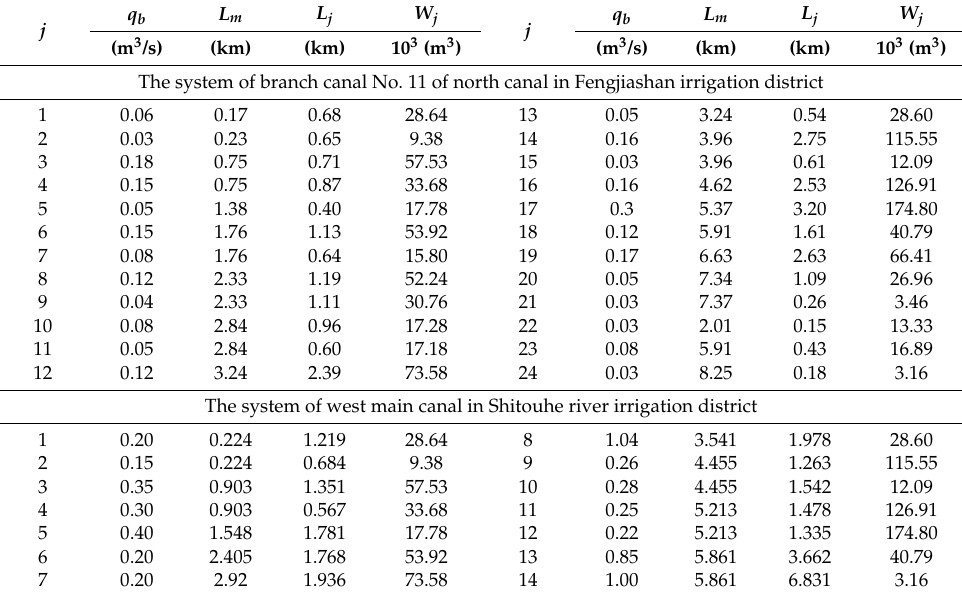
Table 1. Parameters and water requirements of two canal